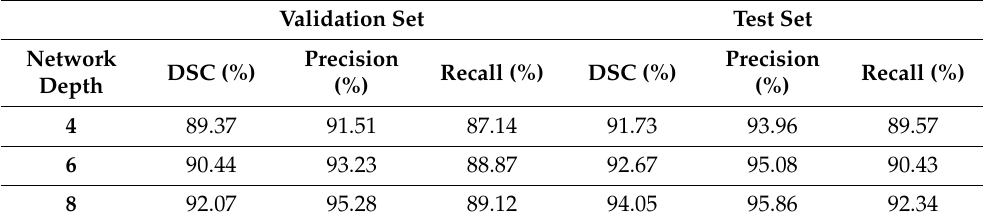
Table 4. DSC, precision, and recall rates of networks with different